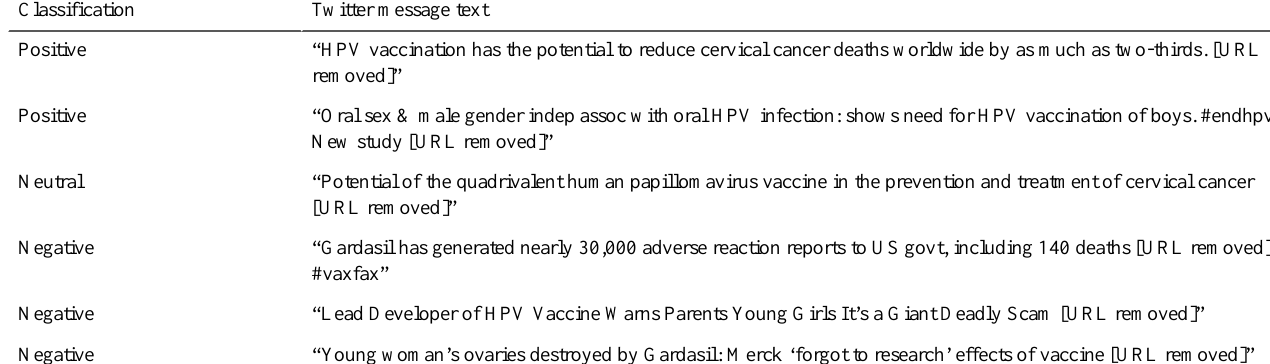
Table 1. Examples of different classes of Twitter messages identified in the searches. Twitter message